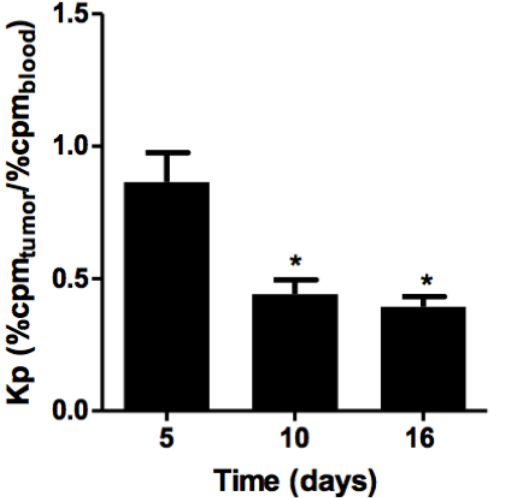
Figure 3. Distribution of 99m Tc-labeled P1G10 in B16F1 tumors. C57BL6 mice ( n = 30) bearing B16F1 melanoma were treated daily with P1G10. Radiolabeled 99m Tc-P1G10 was included with the last treatment, 1 h before dissection. Tumors were removed and blood collected and radioactivity measured in ANSR γ-counter. * p < 0.05 compared to the five-days group, ANOVA, Bonferroni’s post-test